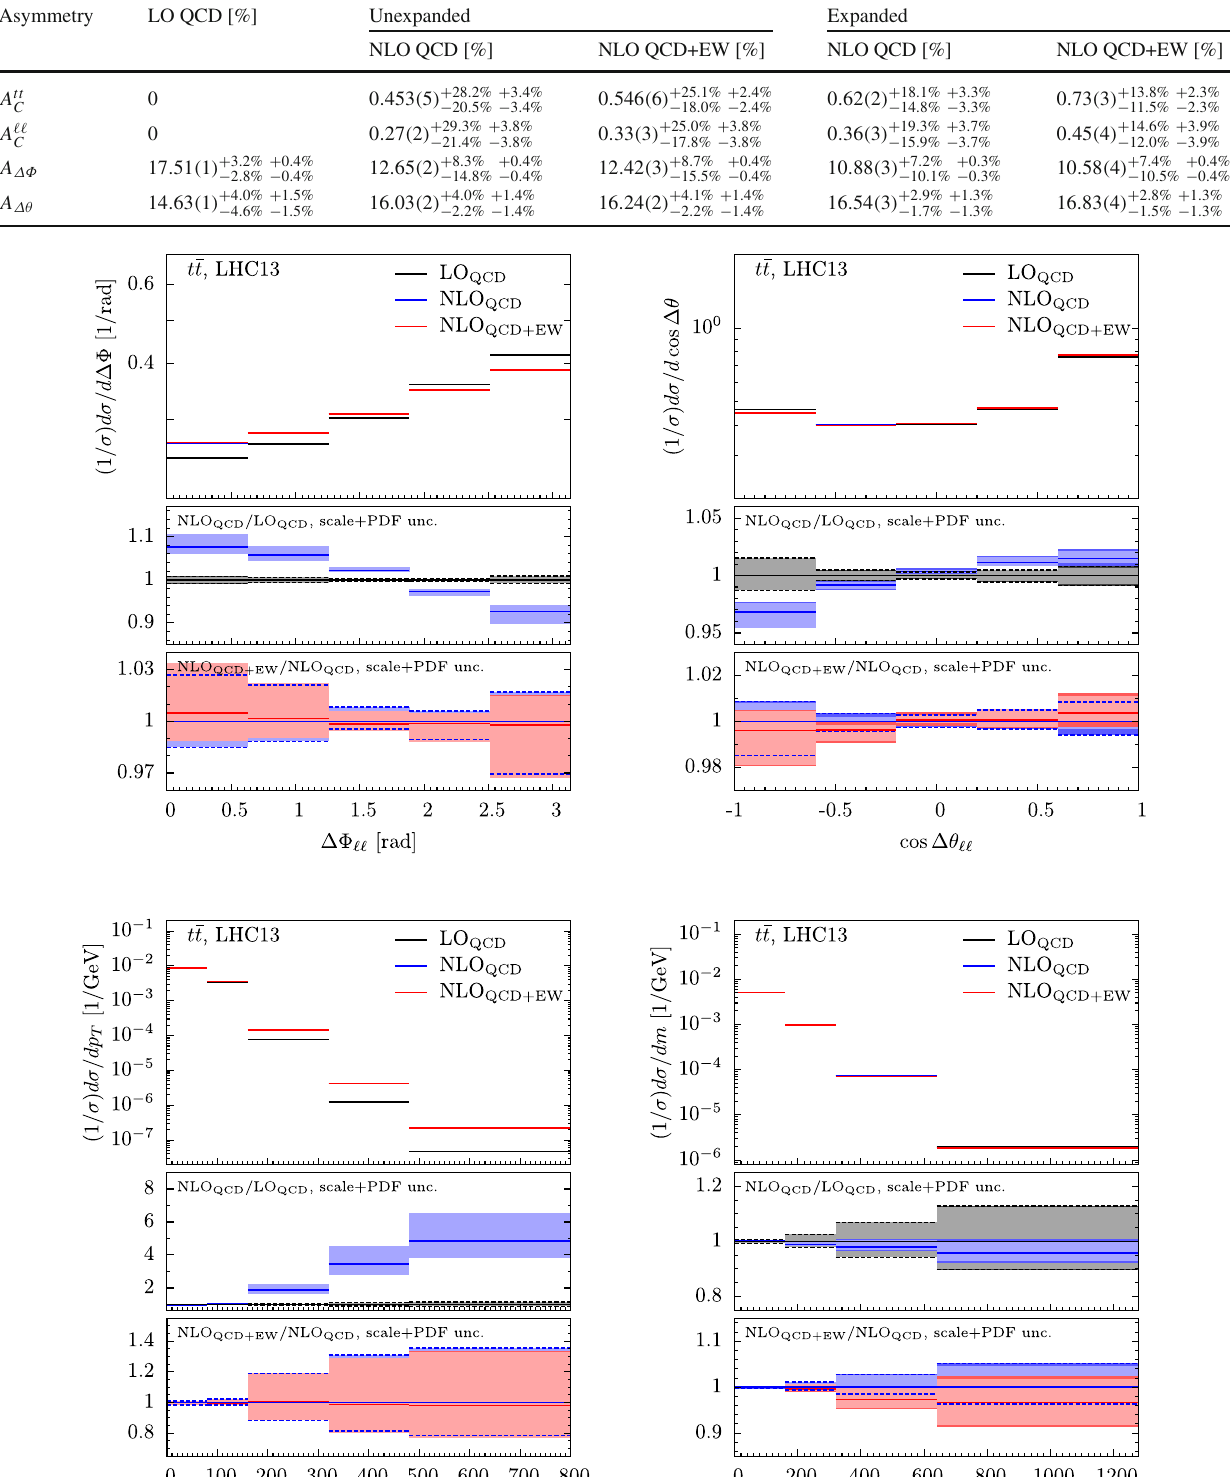
Table 4 Asymmetries at various orders as defined in Sect. 2.3, both expanded and unexpanded